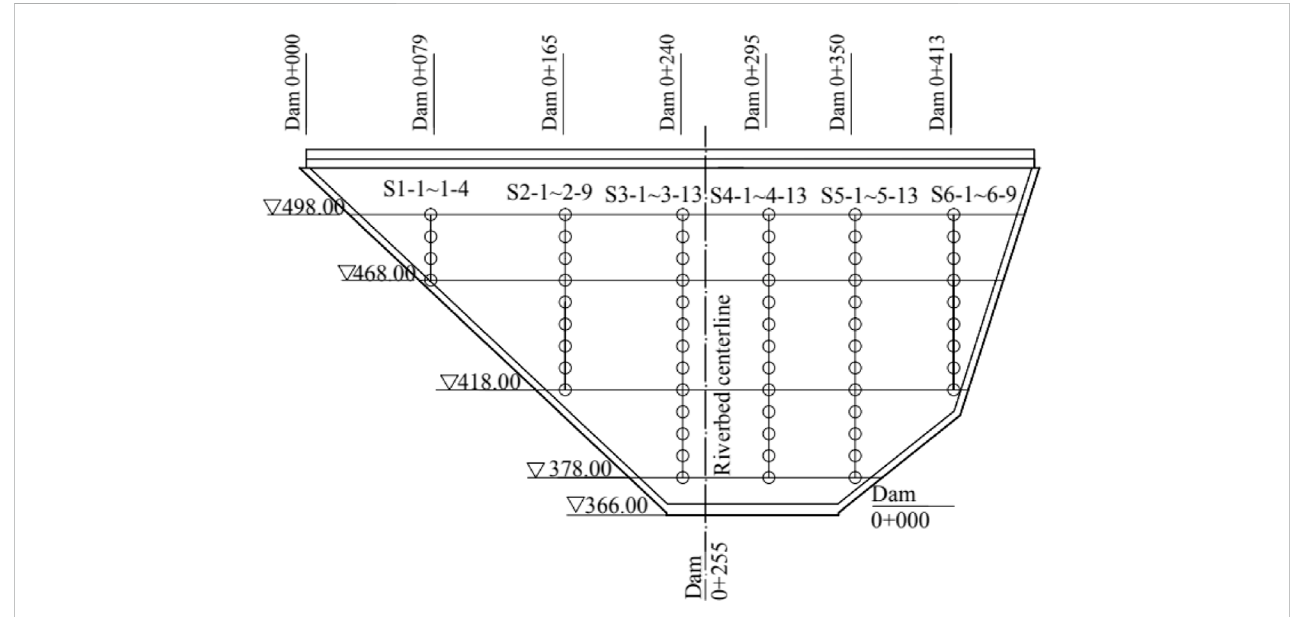
FIGURE 5 Layout of squeezed sidewall deformation monitoring instrument.